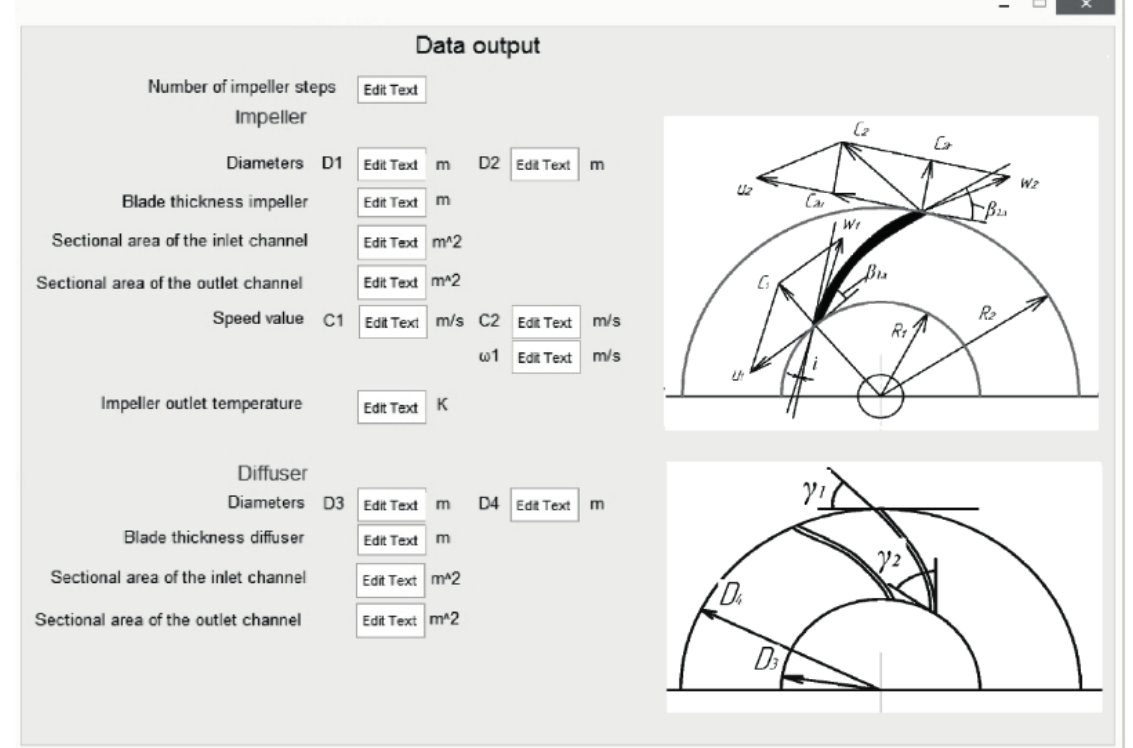
Fig. 4. The second window of the developed UI for the analysis of the calculated parameters of gas dynamics and thermodynamics in the centrifugal